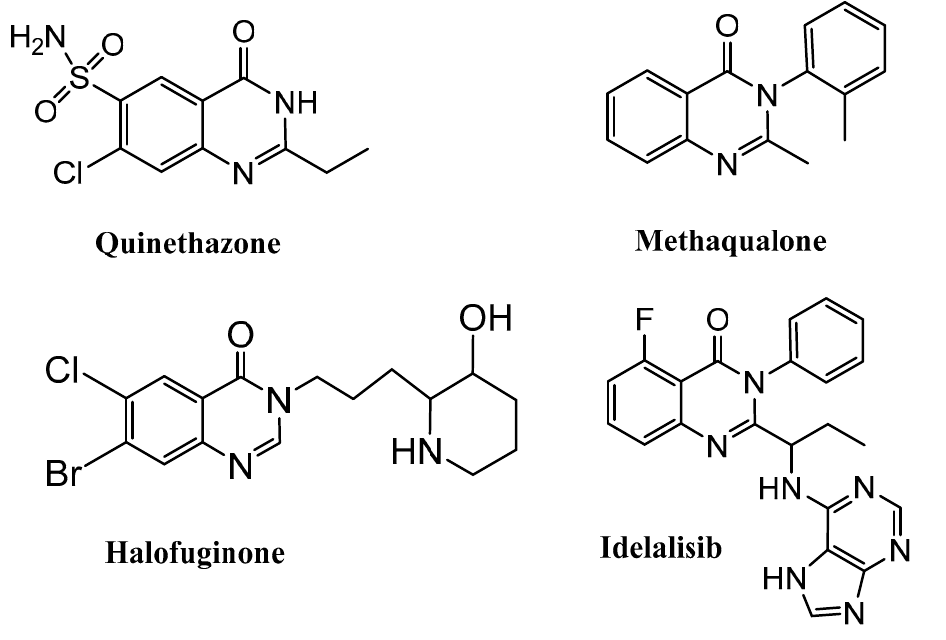
Figure 6 . FDA approved 4(3 H )-quinazolinones [43–48]. Figure 6. FDA approved 4(3 H )-quinazolinones